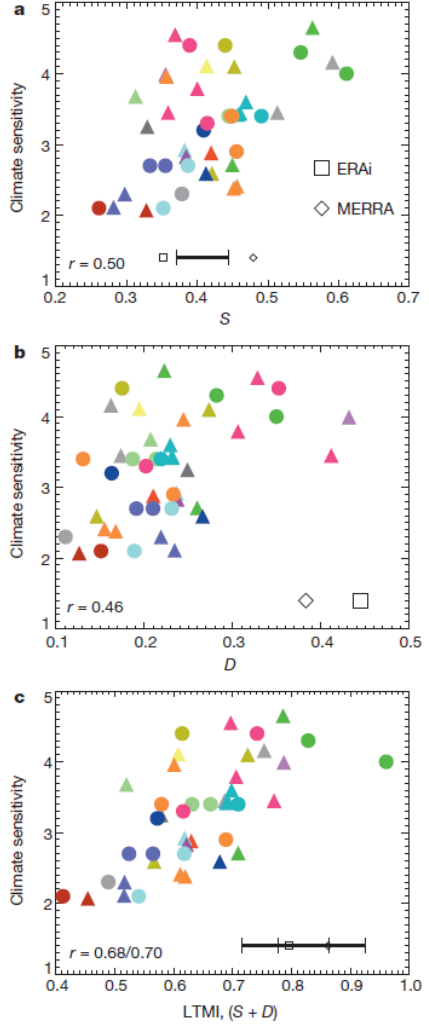
Figure 13. Scatterplot of S (a) , D (b) and LTMI (the sum of S and D ) (c) on the abscissa and the equilibrium climate sensitivity (on the ordinate) from 43 CMIP3 (circles) and CMIP5 models (triangles). Symbol colour identifies the modelling centre of origin. Linear cor- relation coefficients are given in the lower left corner of LTMI with the equilibrium climate sensitivity and the total system feedback, respectively. Two observational estimates for LTMI with error bars are shown on the abscissa, with central values indicated by the un- filled square and diamond. Reprinted from Sherwood et al.